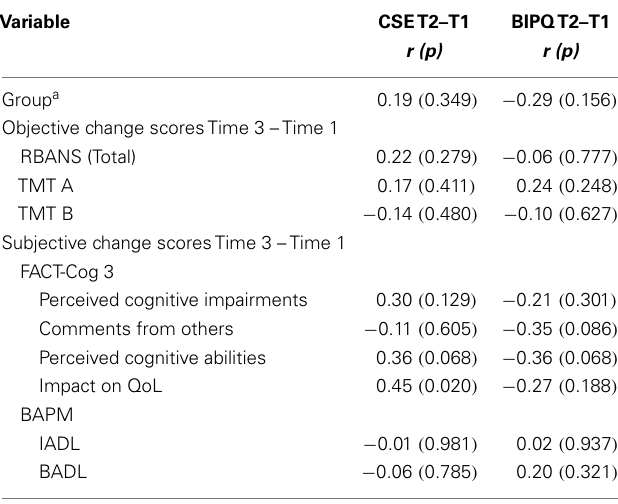
Table 5 | Correlations between change in psychosocial predictors at Time 2 and change in cognitive measures atTime 3